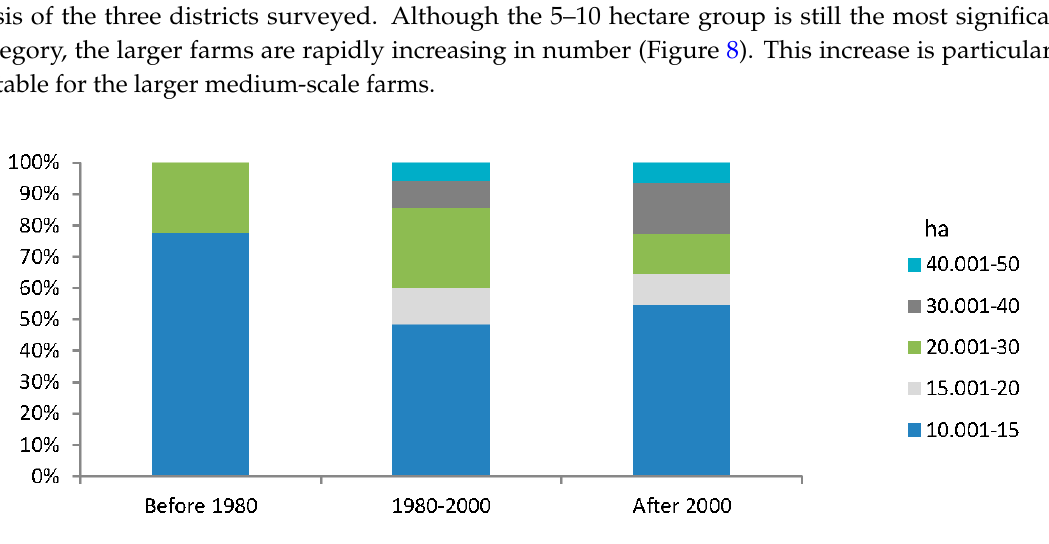
Table 5. Evolution of sampled medium-scale farmers’ * landholding size, in Mchinji, Kasungu and Lilongwe.